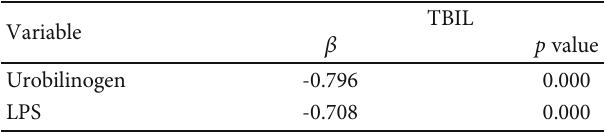
Table 4: Relationship between TBIL, urobilinogen, and